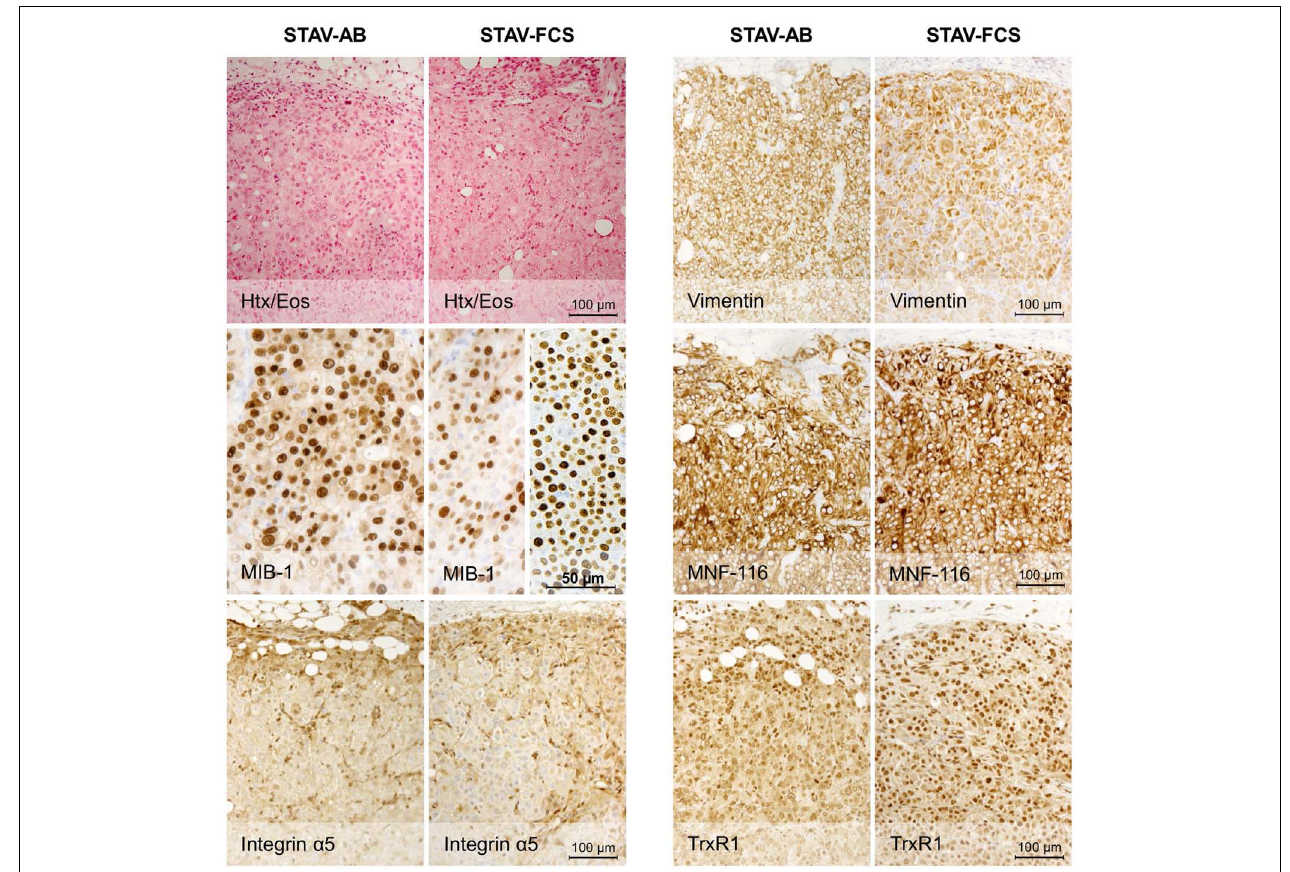
FIGURE 2 | Histological analysis of xenografts and immunohistochemical staining for MIB-1, Integrin α 5, and epithelial and mesenchymal markers . Hematoxylin/eosin staining revealed a similar epithelioid phenotype in xenografts originating from both STAV-AB and STAV-FCS cell sub-lines. MIB-1 staining indicated proliferative activity in both xenografts, however, less vascularized areas of STAV-FCS xenografts (left sub-panel) showed lower labeling index than more vascularized peripheral areas (right